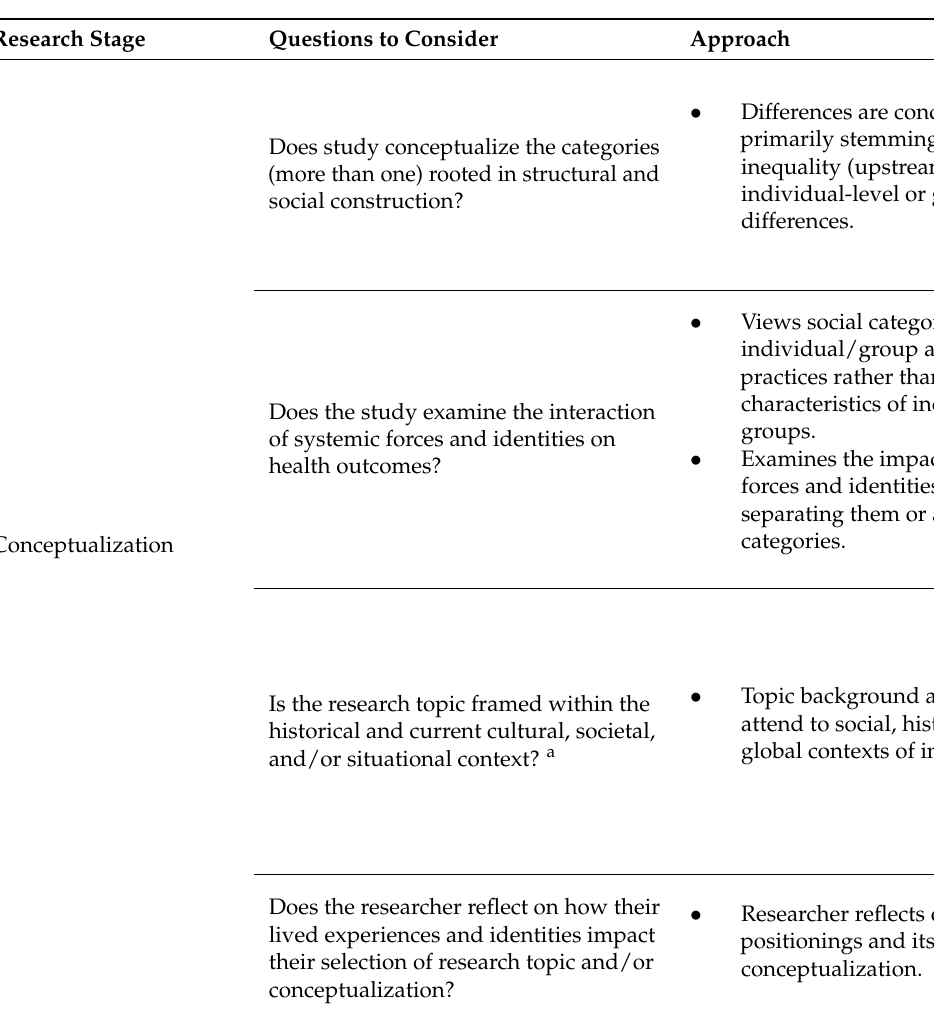
Table 4. Guideline Checklist to Apply Intersectionality Framework in Perinatal Health